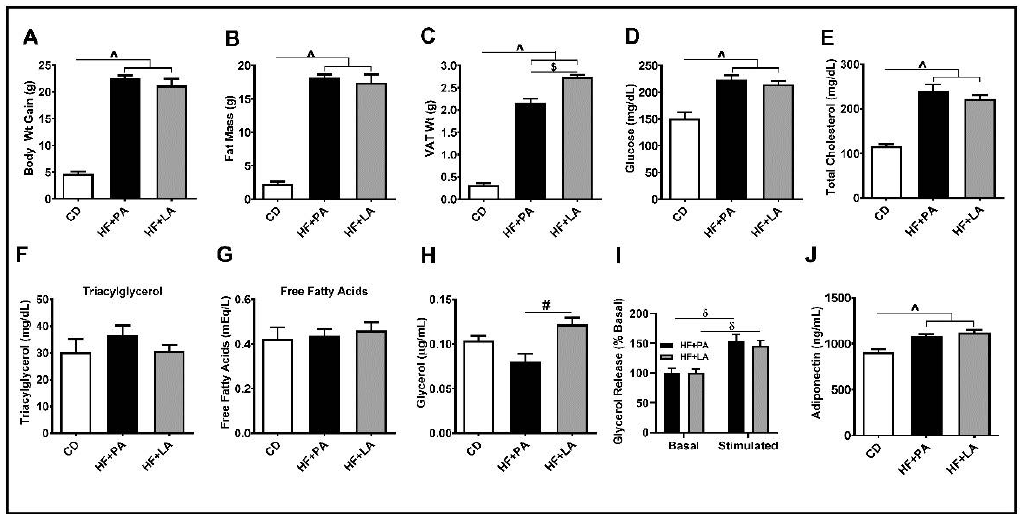
Figure 1. Effect of HF diet supplemented with PA or LA on body weight, fat mass, lipolysis, and systemic metabolic variables in mice. The body weight of mice was recorded at baseline and at 12 wk post-diet and the difference is shown ( A ). The total fat mass was measured in live mice at 12 wk post-diet by an EchoMRI body composition analyzer ( B ). VAT mass was measured after euthanasia ( C ). Blood glucose ( D ) and plasma lipids such as total cholesterol ( E ) and triglycerides ( F ) were assessed. As markers of adipose tissue (AT) lipolysis, plasma free fatty acids ( G ) and glycerol ( H ) were measured. Basal and stimulated lipolysis was assessed ex vivo in VAT from HF-fed mice ( I ) and plasma adiponectin levels were determined by ELISA ( J ). Values are expressed as mean ± SEM of 6–8 samples in each group. ^ p < 0.001 versus CD; # p < 0.01; $ p < 0.001 versus HF + PA; δ p < 0.01 versus basal. VAT, visceral adipose tissue; CD, chow diet; HF + PA, high fat + palmitic acid; HF + LA, high fat + lauric acid.